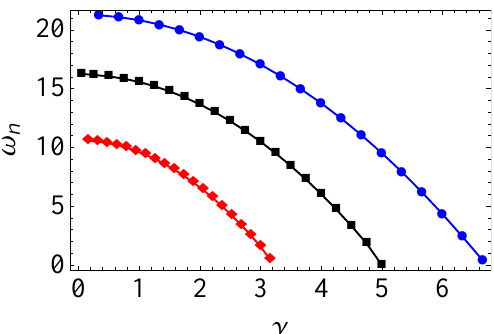
Figure 10. The natural frequency for different ξ with α = 50, p = 0.04, k s = 0.01 fixed, from top to bottom ξ 1 =